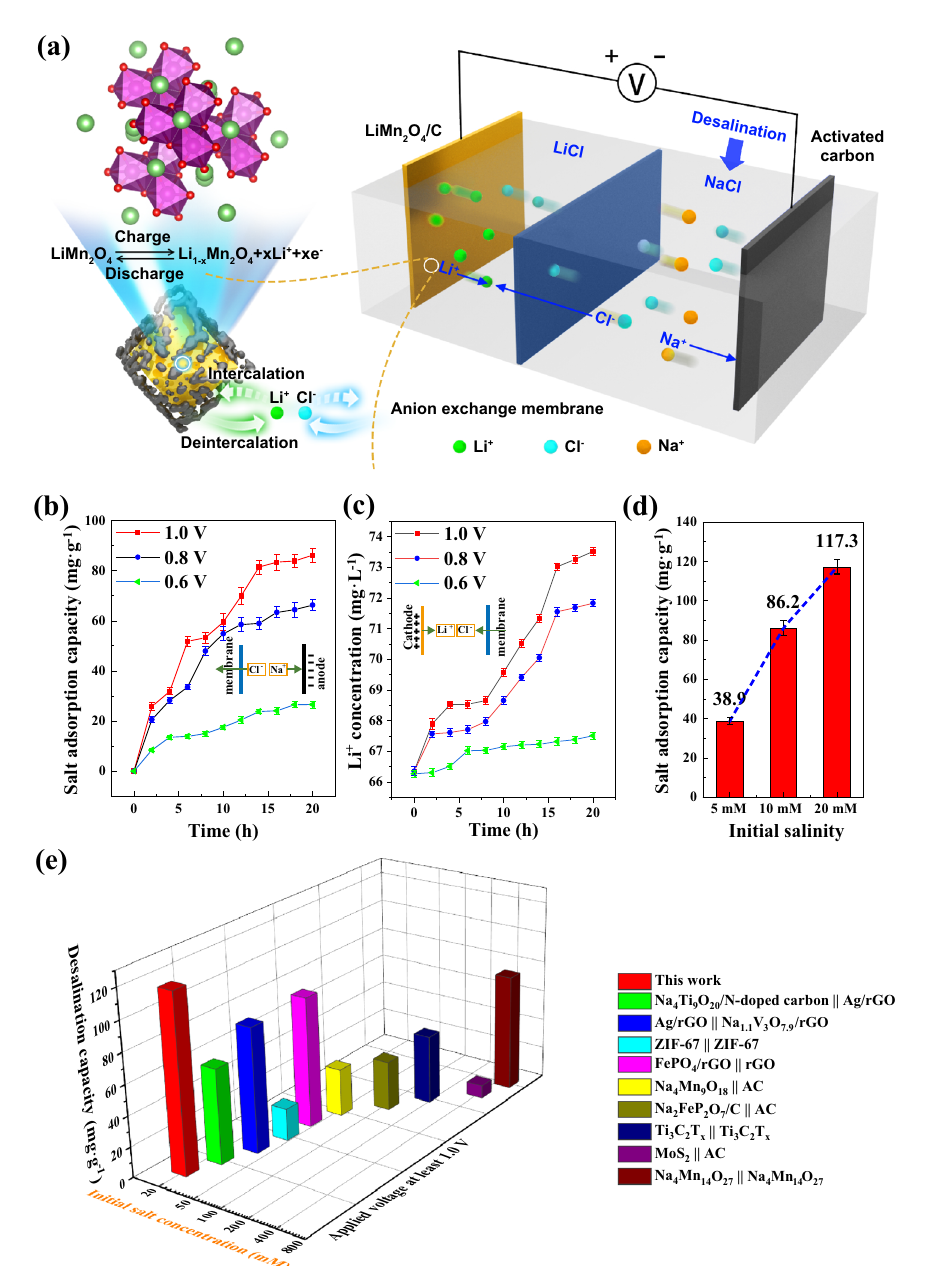
Fig. 4 a Schematic diagram of the deionization cell. b Salt removal capacities of the deionization cell and c lithium release of LiMn 2 O 4 /C in 10 mM LiCl solution during desalination at different voltages. d Salt removal performances with a variation of initial NaCl concentration at 1.0 V. e Desalination performance comparison of different battery electrodes for